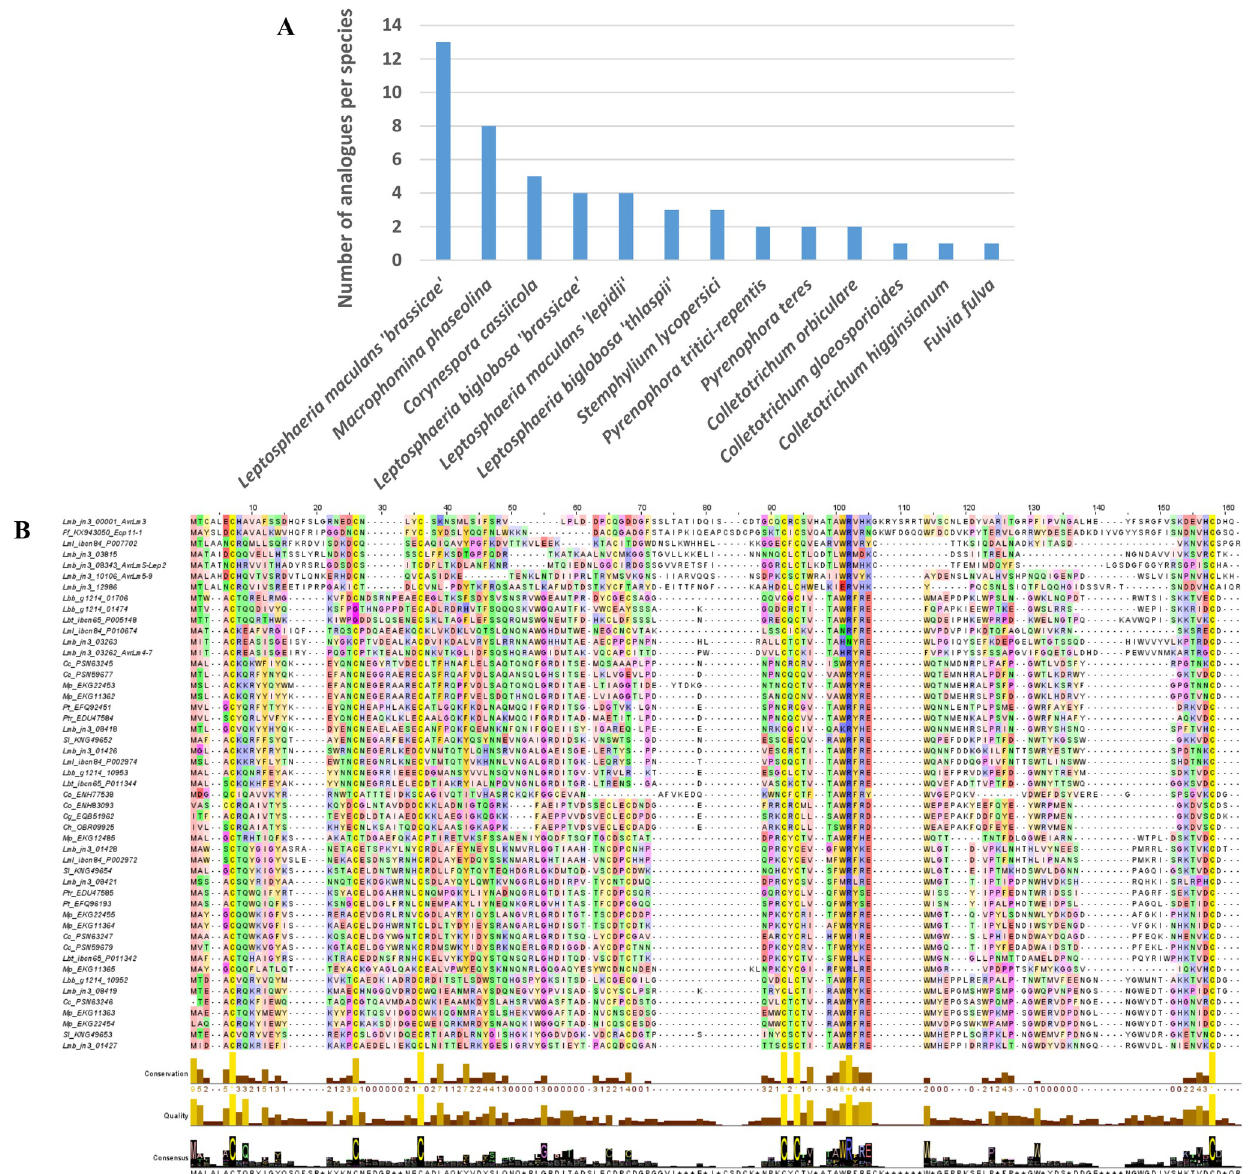
Fig 5. Identification of LARS effector structural analogues in L . maculans ‘brassicae’ and other phytopathogenic fungi. (A) Species distribution of number of structural analogues of AvrLm4-7, AvrLm5-9 and Ecp11-1 found with a low-stringency HMM search on a database encompassing 163 predicted proteomes of 116 fungal species. (B) Multiple sequence alignment of the 50 potential structural analogues and the sequences of the known structures (AvrLm4-7 = 4fprA / AvrLm5-9 = 0a59A / Ecp11-1 = 0cp1A). The secondary structures of the latter were calculated using the software STRIDE and were added at the bottom of the alignment (H = helix, G = 3–10 helix, E = β strand, B = β bridge, C = coil, T = turn) above the residue conservation measure, the local alignment quality and the consensus logo. The alignment was displayed using the software Jalview. In the displayed alignment, amino acids which do not align with any of the three sequences AvrLm4-7, AvrLm5-9 and Ecp11-1 have been removed. Cg, Colletotrichum gloeosporioides ; Ch,